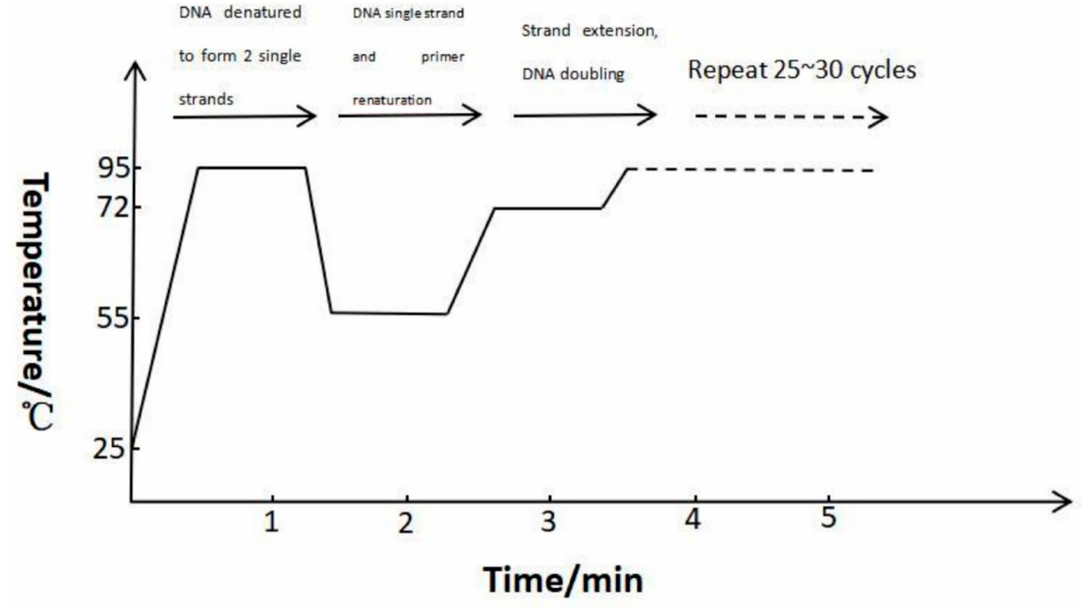
Figure 1. The process diagram of mPCR. Firstly, DNA denatured to form two single strands at 95 ◦ C. Then, DNA forms a single strand and primer renatures at 55 ◦ C. Next, strand extension and DNA doubling at 72 ◦ C. Finally, whole process repeats 25~30